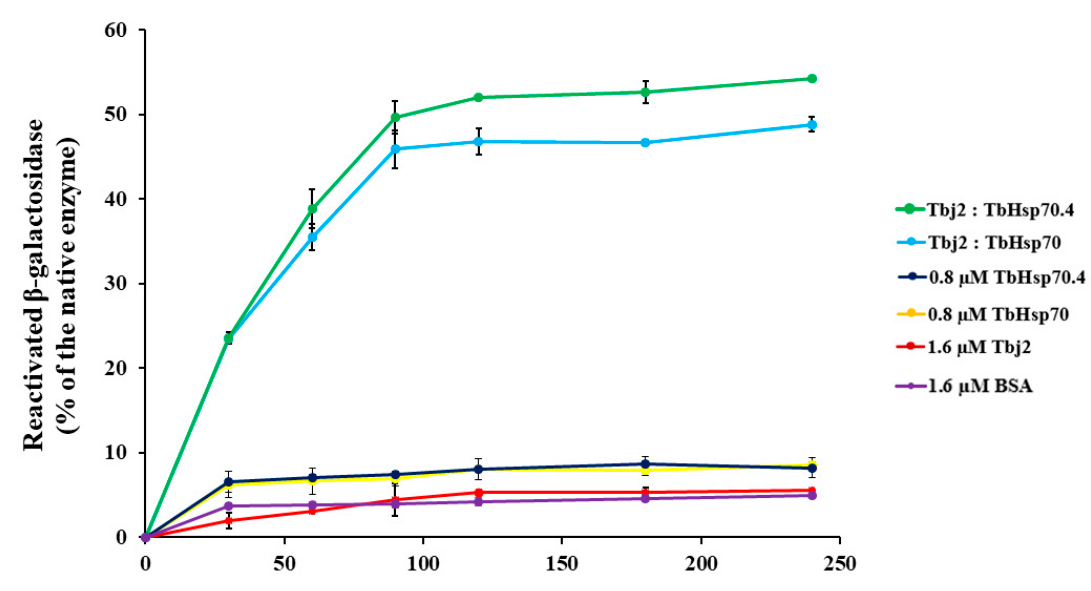
Figure 5. Tbj2 stimulates the refoldase activity of TbHsp70 and TbHsp70.4. Chemically-denatured β -galactosidase (3.4 nM) was diluted into refolding bu ff er containing the indicated Hsp70 and / or Tbj2 mixtures. β -galactosidase assays were performed as previously described [37]. Recovery of activity of denatured β -galactosidase by the various molecular chaperone mixtures was measured by its ability to convert substrate o-nitrophenyl- β -D-galactoside (ONPG) to yellow ortho-nitrophenol (ONP), and this absorbance was recorded at 420 nm. The negative control consisted of BSA (1.6 µ M) added to denatured β -galactosidase enzyme to determine the kinetics of spontaneous refolding of the denatured β -galactosidase enzyme. Results are expressed as % β -galactosidase activity of the refolded enzyme in relation to native enzyme. Standard deviations were obtained from three replicate assays on three independent batches of purified